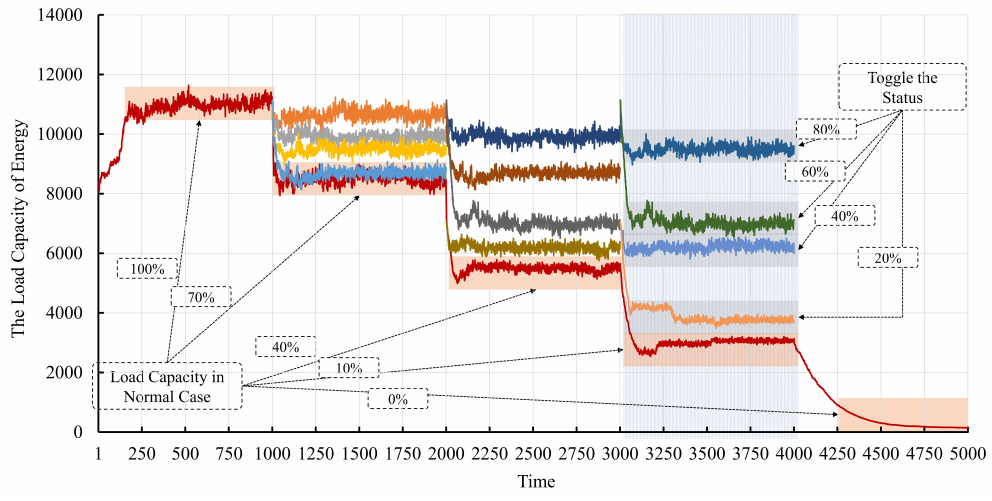
Figure 4. The history of the energy consumption at the